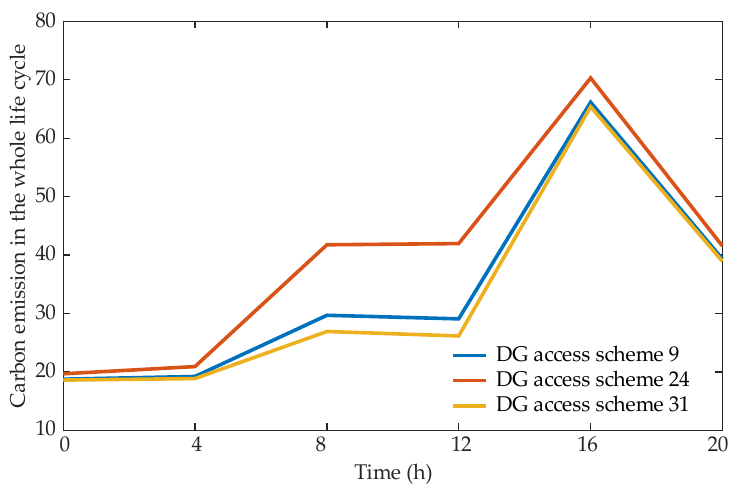
Figure 6. The carbon emission in the full life cycle of schemes 9, 24 and 31 under scenario 5.